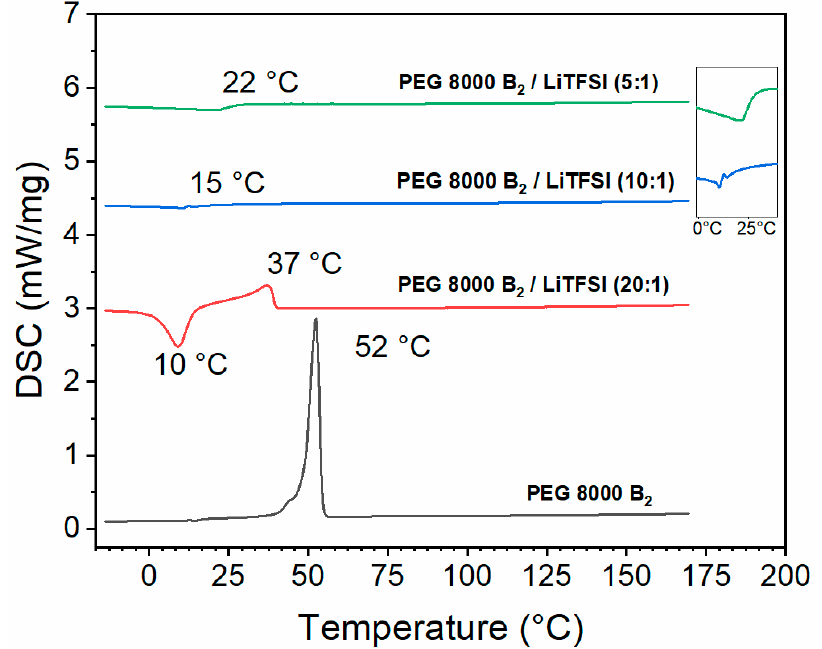
Figure 5. Differential scanning calorimetry (DSC) results of PEG 8000 B 2 without any additives and PEG 8000 B 2 with different amount of mixed LiTFSI (20:1( 10 ), 10:1 ( 9 ), 5:1 ( 8 )).